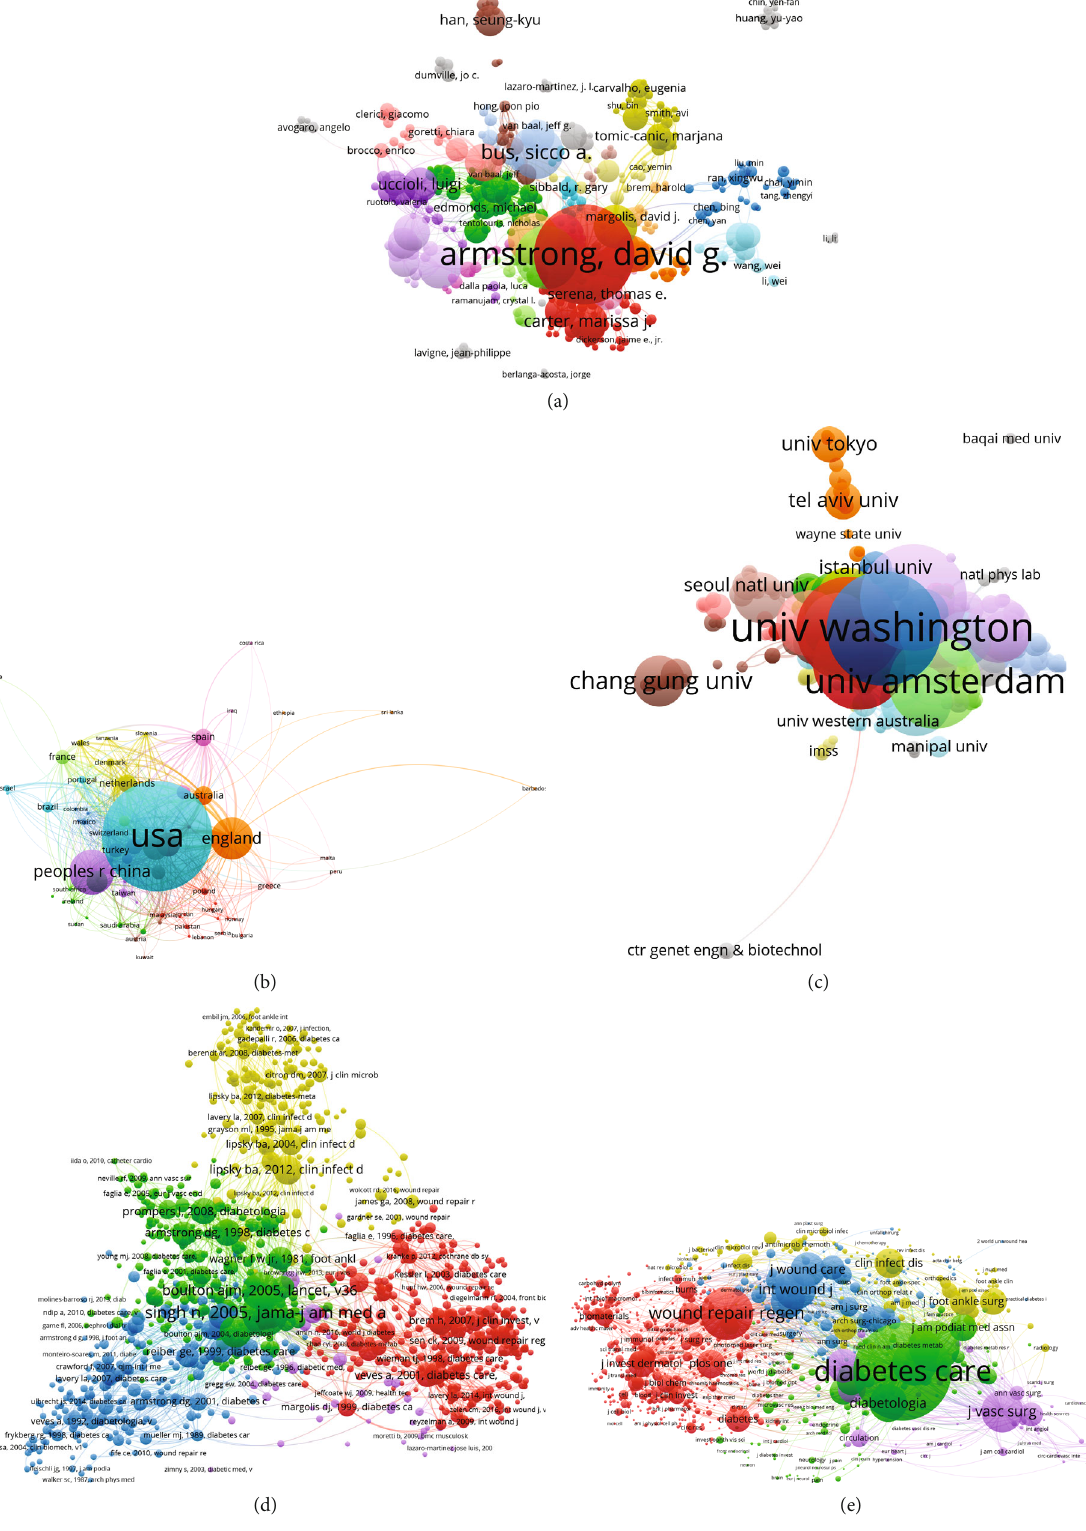
Figure 8: Coauthorship and cocitation analyses of global research on DFU. (a) Mapping of coauthorship analysis amongst 556 identi fi ed authors on DFU research. (b) Mapping of 72 identi fi ed countries by coauthorship analysis on DFU research. (c) Mapping of coauthorship analysis amongst 579 institutions in the DFU fi eld. (d) Mapping of 1000 included publications by cocitation analysis on DFU research. (e) Mapping on 1000 included journals by cocitation analysis in this fi